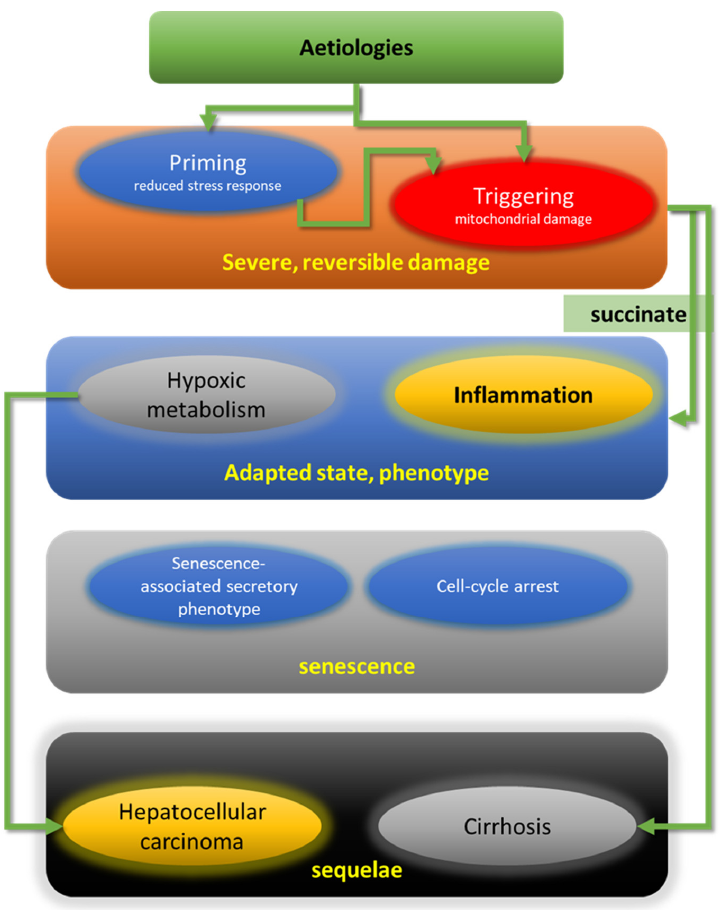
Figure 1. Overview on the PTAS model for steatohepatitis.